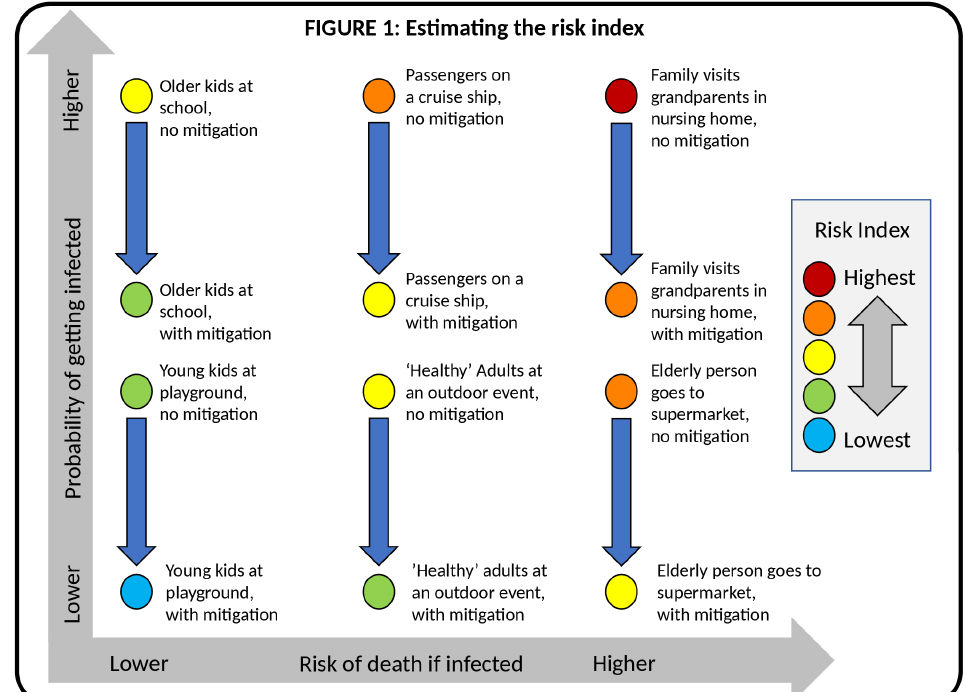
Figure 1. Estimating the risk